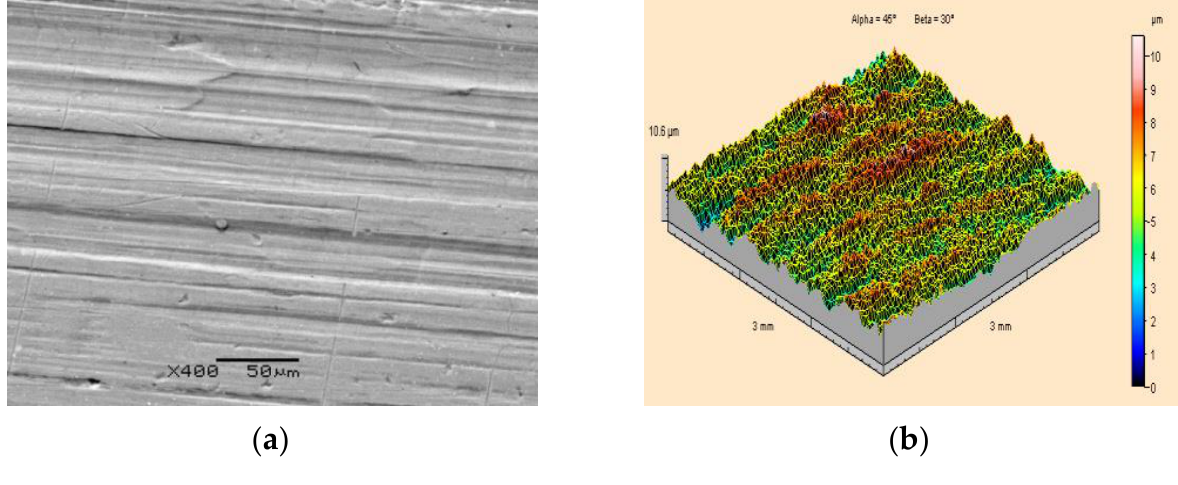
Figure 6. Surface topography of a PA2 aluminium alloy specimen prior to the application of paint coating and before high-pressure water-ice jet treatment: ( a ) Scanning electron microscope image (400 × magnification); ( b ) Isometric image.